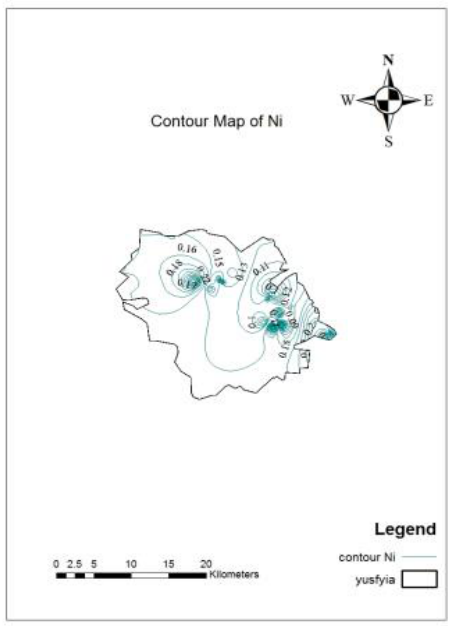
Fig.15: The interpolation and contour line of Ni map in